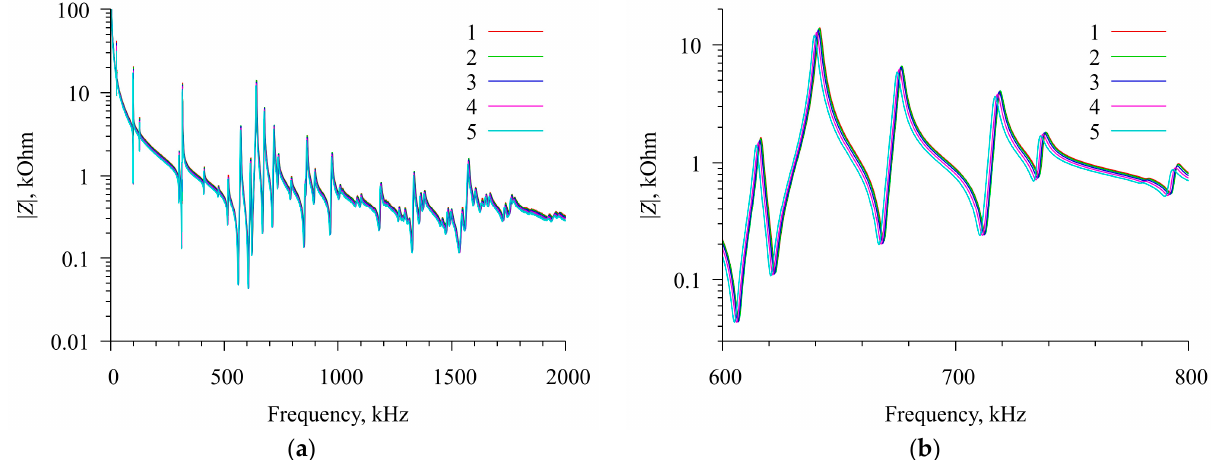
Figure 4. Frequency dependencies of the module of the electrical impedance of a free radial electric field excited resonator at different temperatures. ( a ) General view of dependencies; ( b ) magnified view in the range of 600–800 kHz. Curves 1—25 °C, 2—30 °C, 3—35 °C, 4—40 °C, and 5—45 °C.